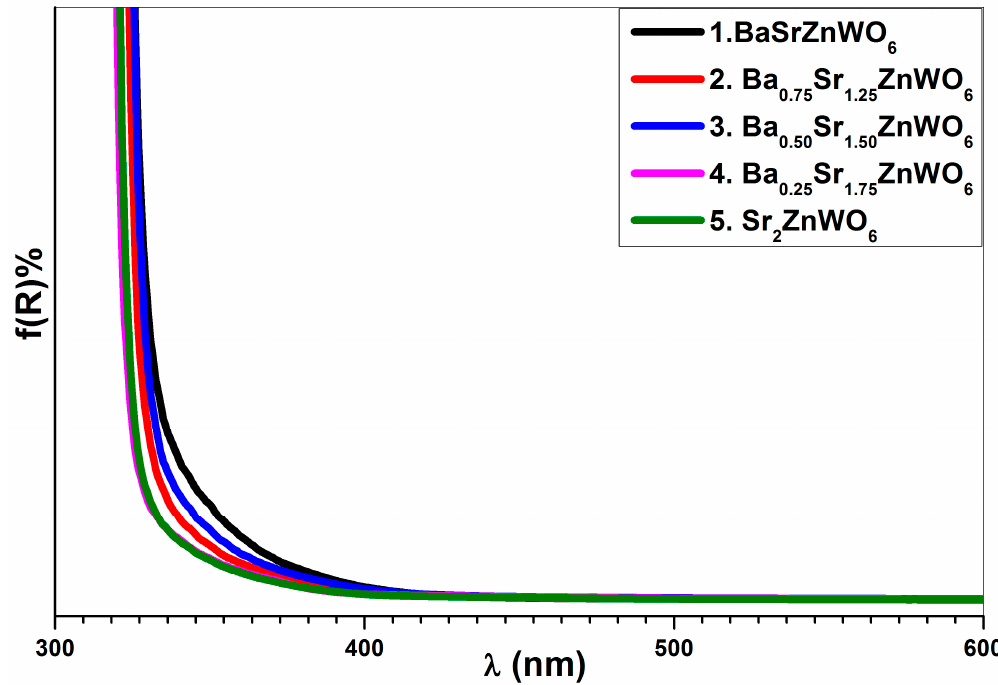
Figure 9. Absorbance (KM function) as a function of wavelength for the Ba 2 − x Sr x ZnWO 6 (x = 1, 1.25, 1.50, 1.75, 2) double perovskite series.